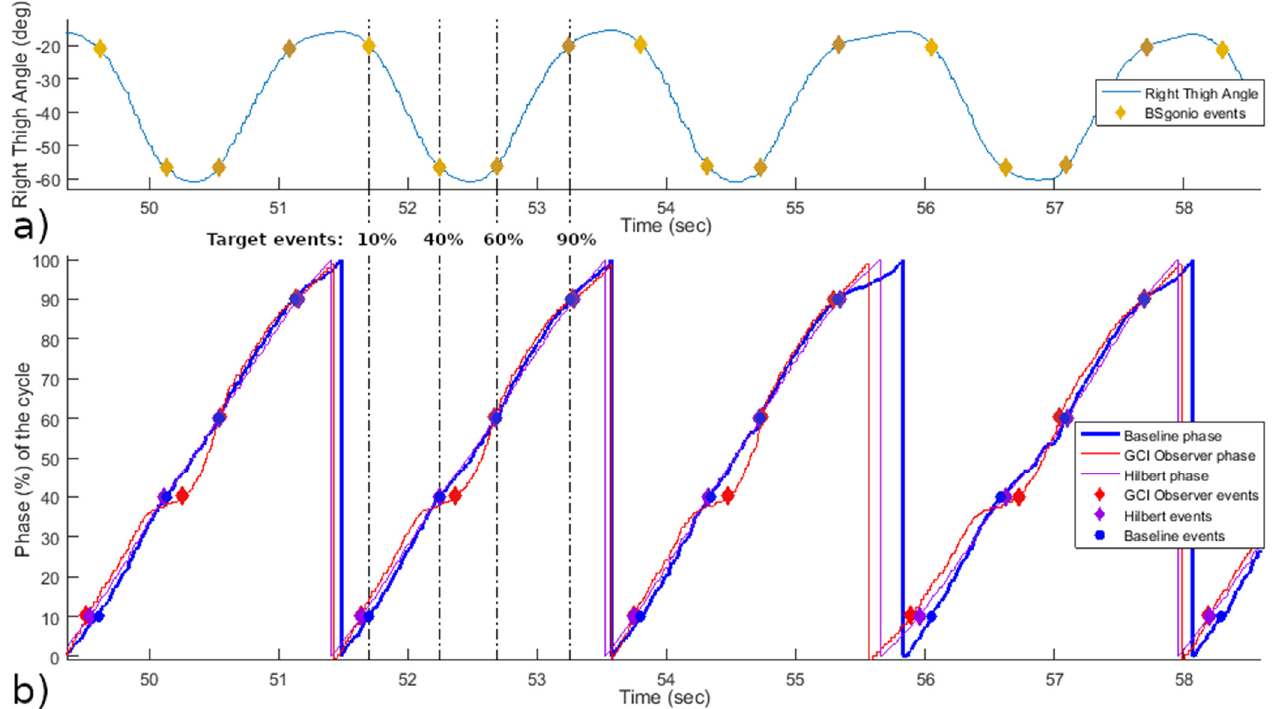
Figure 3. Representative data from subject 1 showing the right thigh angle on the top ( a ) and the phase estimations on the bottom ( b ). On the bottom graph, the blue line is the baseline reference, the red line is the GCI Observer output phase interpretation, and finally in purple, the Hilbert phase estimation. Corresponding events detected by the algorithms are shown superimposed on their respective line. Target events from the baseline in the second cycle are highlighted with vertical lines to help visual comparison with the corresponding event detections from the other algorithms. Table 2. Algorithms respective results presented in percentage of cycle